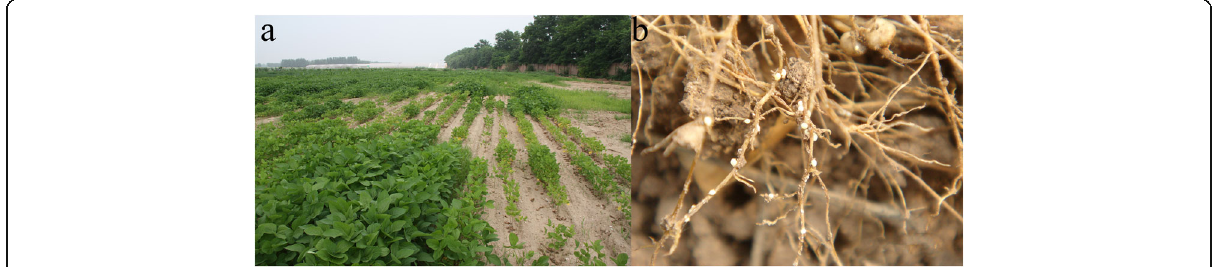
Fig. 1 A soybean field severely infected with soybean cyst nematode (SCN, Heterodera glycines ) ( a ), and white females of SCN on an infected soybean root ( b